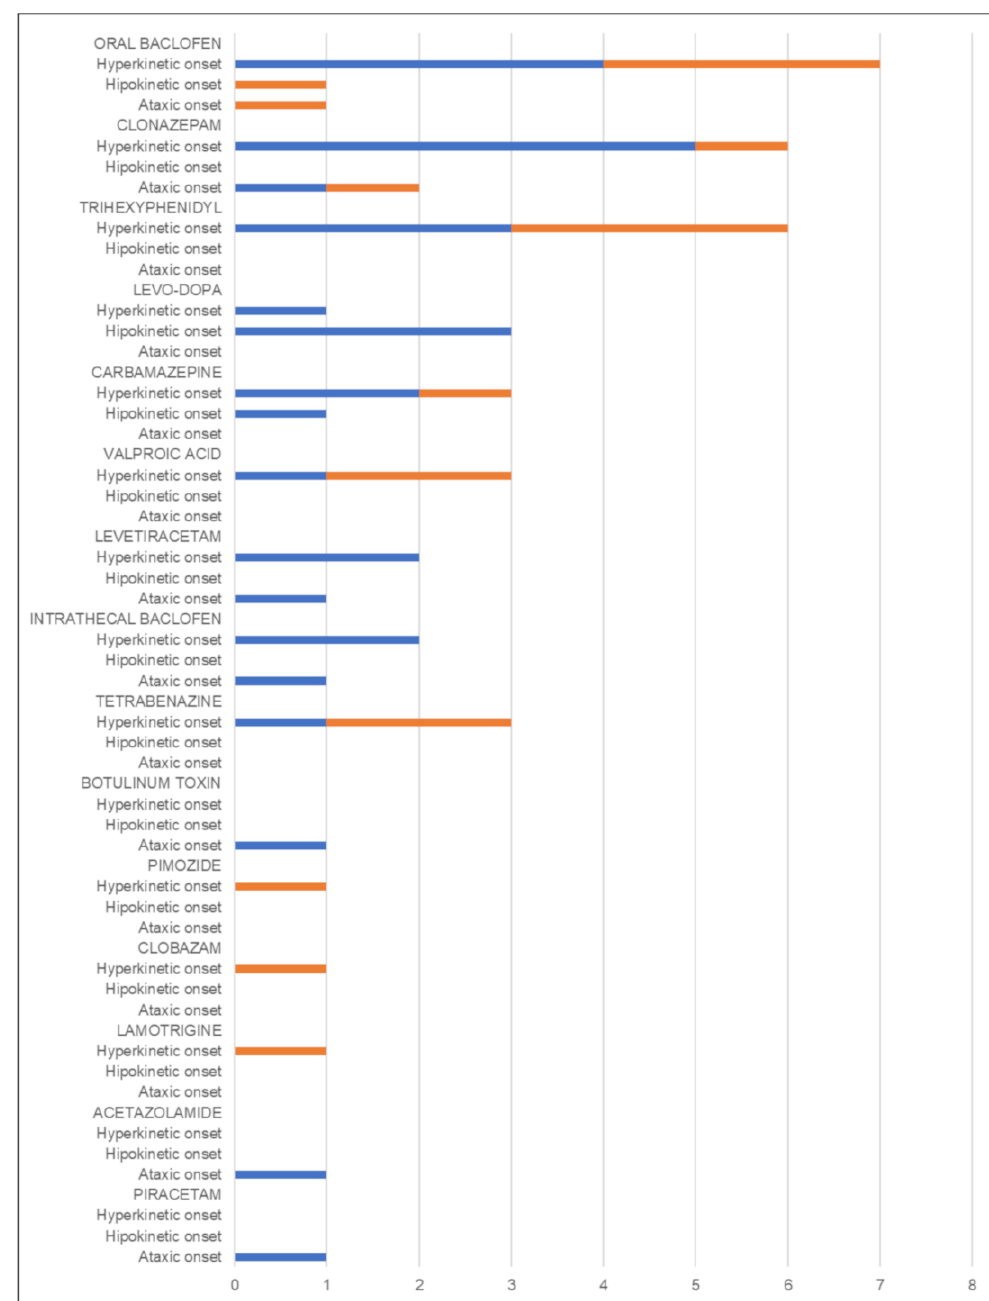
Figure 3. Use and efficacy of pharmacological treatments in patients with mitochondrial movement disorders. Values are reported as number of patients. Blue bars indicate the number of patients for whom the treatment was described as effective in modulating the movement disorder. Orange bars indicate the number of patients for whom the treatment was described as not effective in modulating the movement